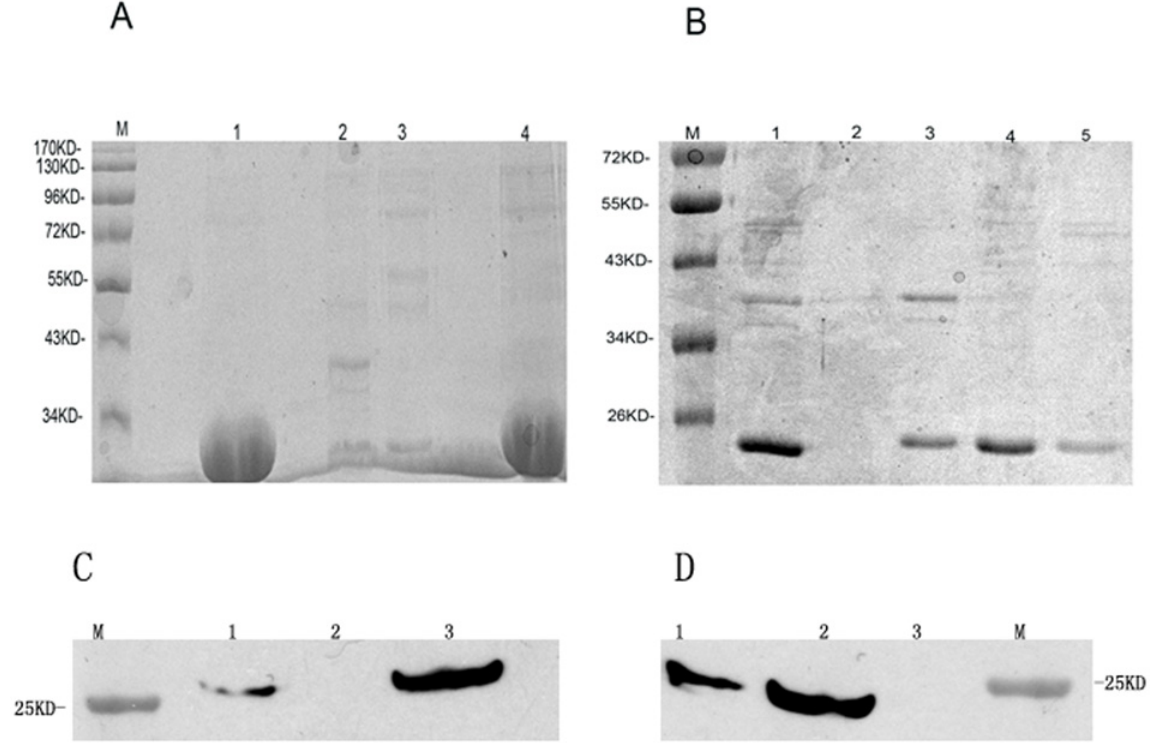
Fig 1. Purification and identification of recombinant proteins. Proteins were purified and identified by SDS-PAGE and Western blot analysis. (A) Lane M, marker; lane 1, HE-ORF2-tuftsin purified by DEAE chromatography; lanes 2 and 3, lysate of non-transformed BL21(DE3) cells; lane 4, HE-ORF2 purified by DEAE chromatography; (B) lane M, marker; lane 1, HA-VP1-tuftsin inclusion bodies dissolved with urea; lane 2, lysate of the non-transformed BL21(DE3) cells; lane 3, HA-VP1 inclusion bodies dissolved with urea; lane 4, HA-VP1-tuftsin purified by DEAE chromatography; lane 5, HA-VP1 purified by DEAE chromatography. (C) Western blot analysis of purified HE-ORF2-tuftsin and HE-ORF2. Lane M, marker; lane 1, HE-ORF2; lane 2, healthy serum control; lane 3, HE-ORF2-tuftsin. (D) Western blot analysis of purified HA-VP1-tuftsin and HA-VP1. Lane M, marker; lane 1, HA-VP1-tuftsin; lane 2, HA-VP1; lane 3, healthy serum